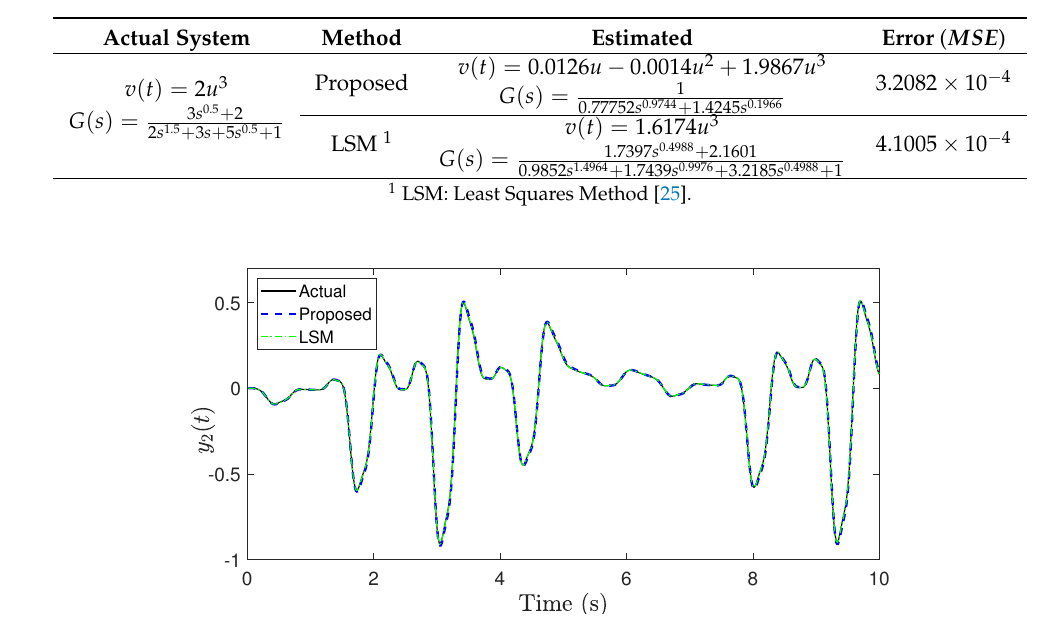
Figure 7. Overall time response comparison for Example